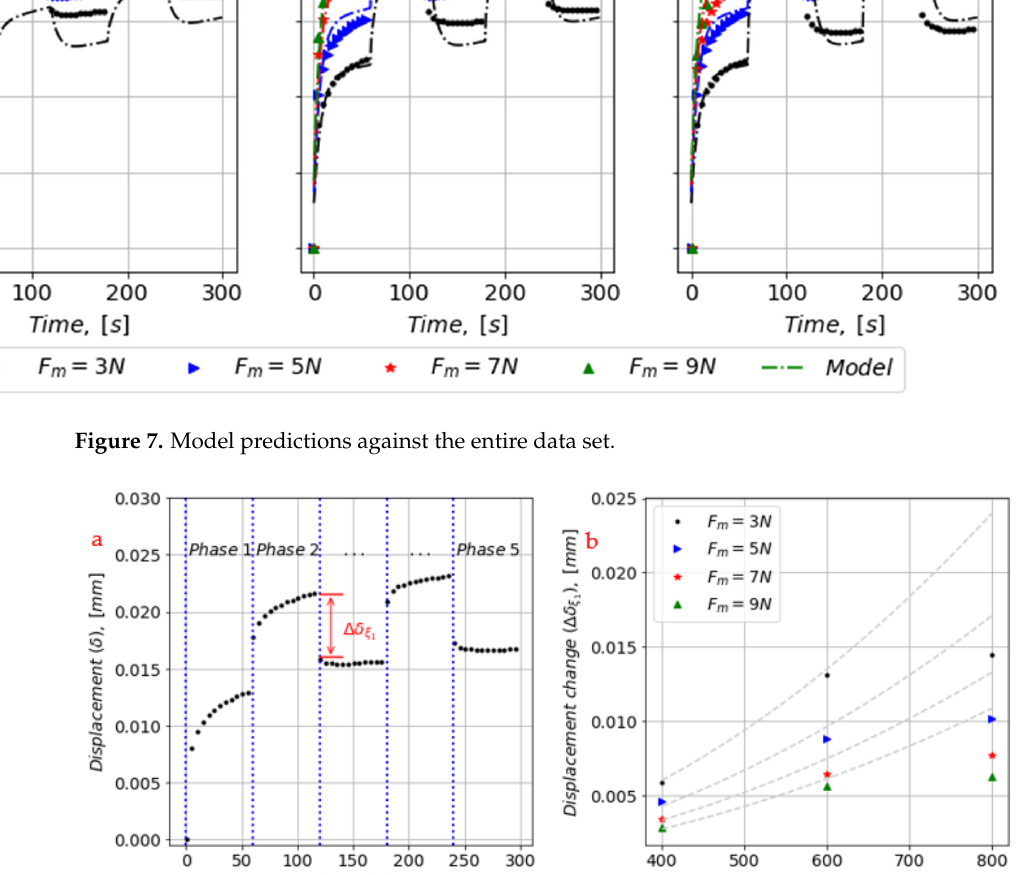
Figure 7. Model predictions against the entire data set.